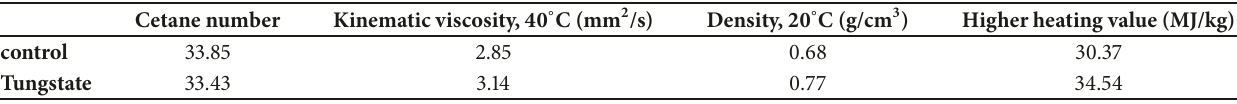
Table 2: Physicochemical properties of the biodiesel using empirical equations in treated and nontreated culture by sodium tungstate